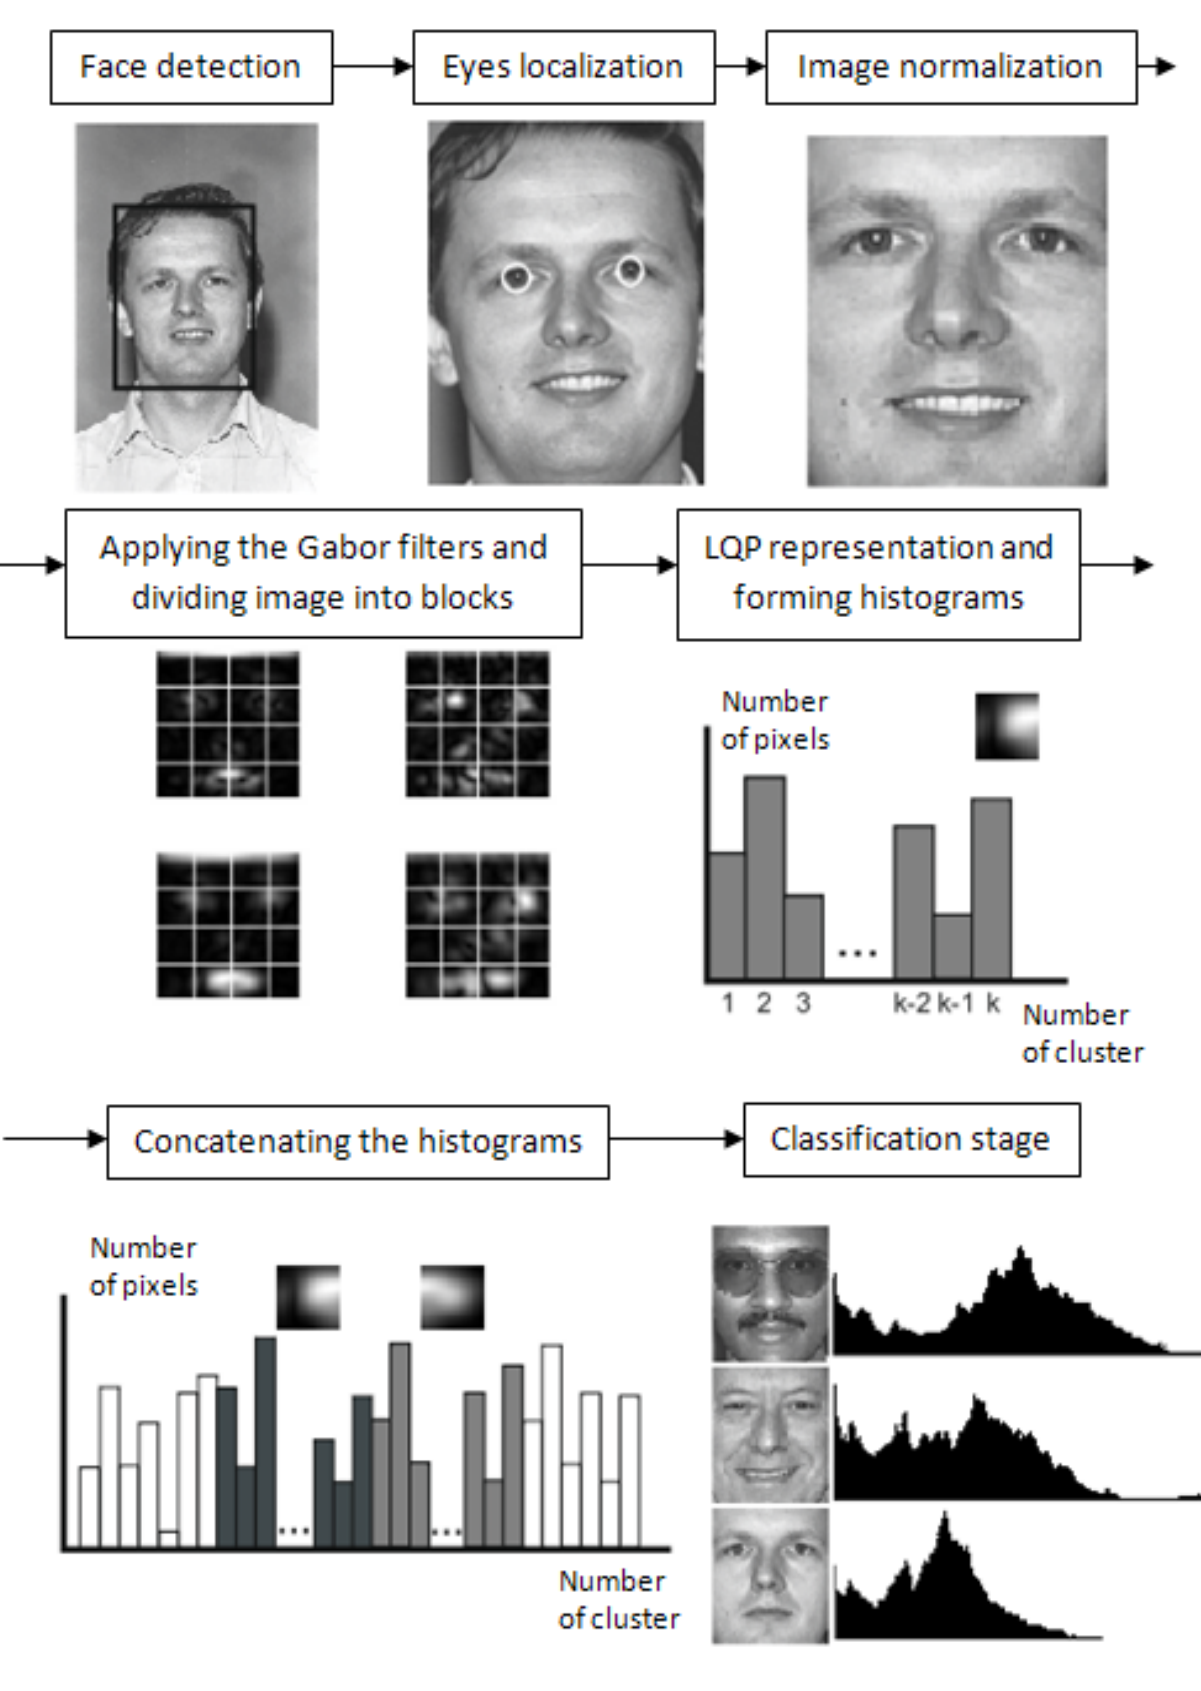
Figure 1. Block diagram of face recognition